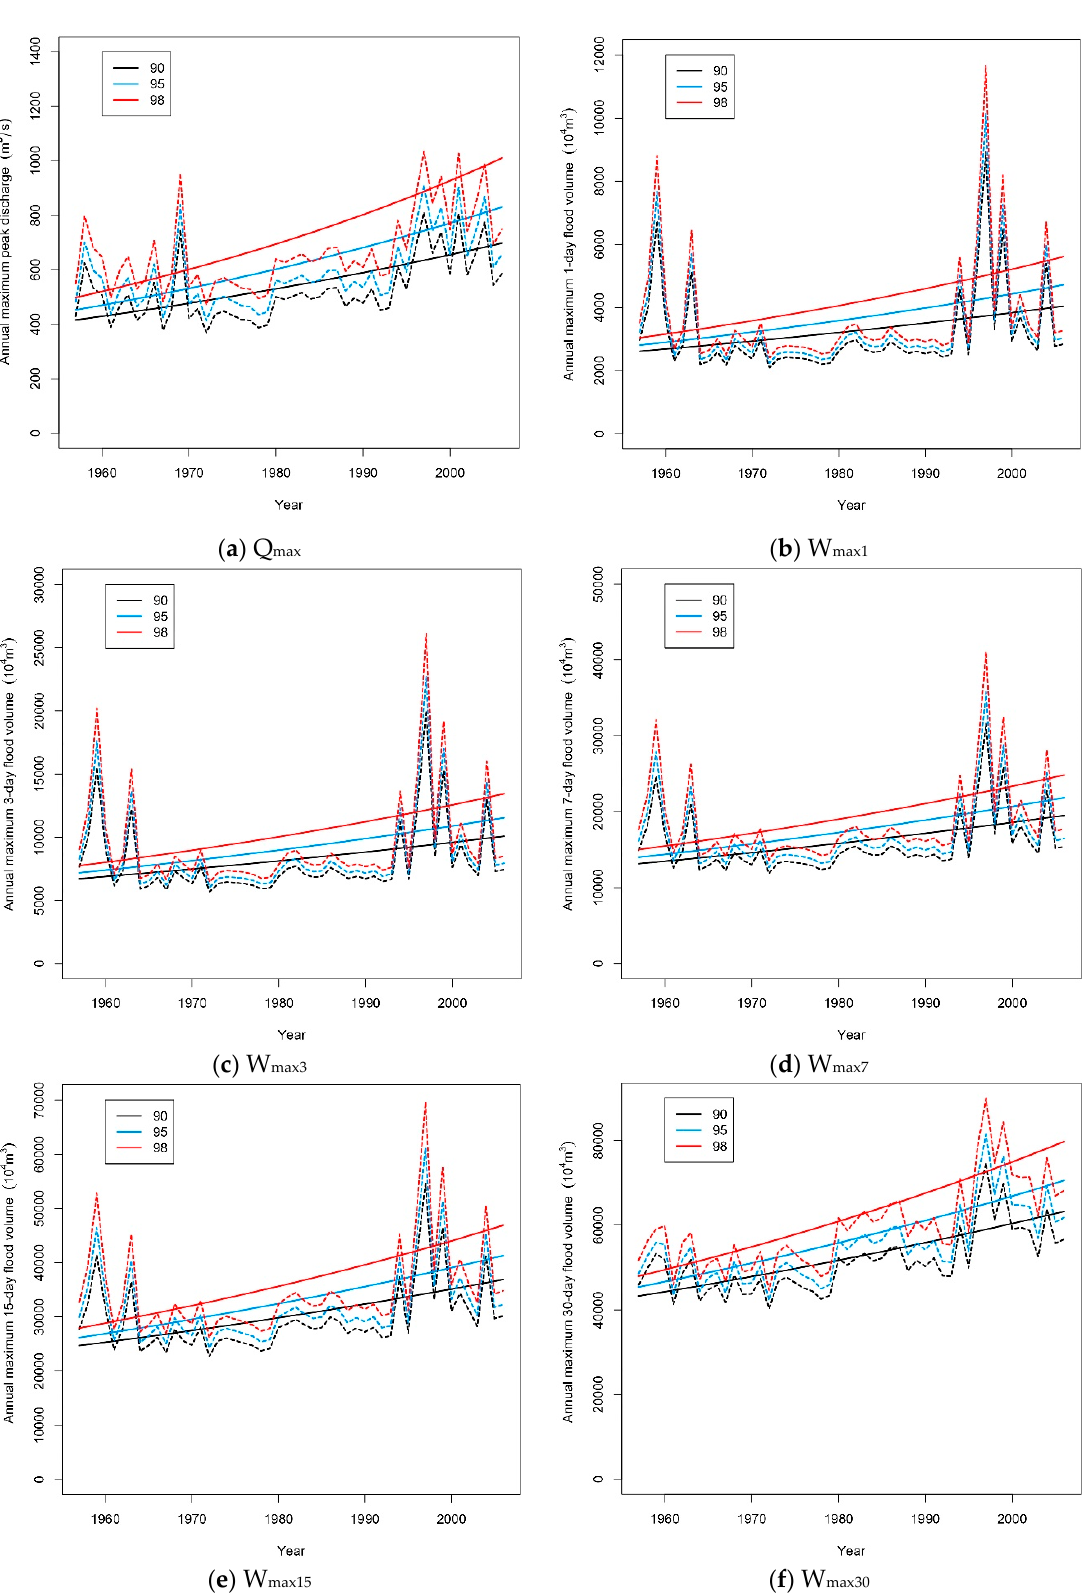
Figure 8. The 90%, 95% and 98% quantile plots of the optimal fitting distributions for Model 1 and Model 2.